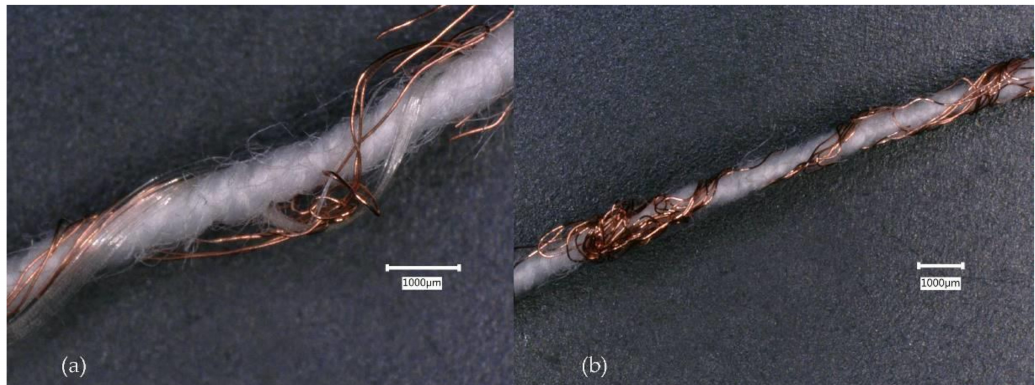
Figure 4. Broken strands of multi-strand copper wire removed from E-yarns after failures during wash testing with tumble-drying: ( a ) Conductive wire E-yarn with Vectran ™ at 50X magnification; ( b ) Conductive wire E-yarn without Vectran ™ at 30X magnification.